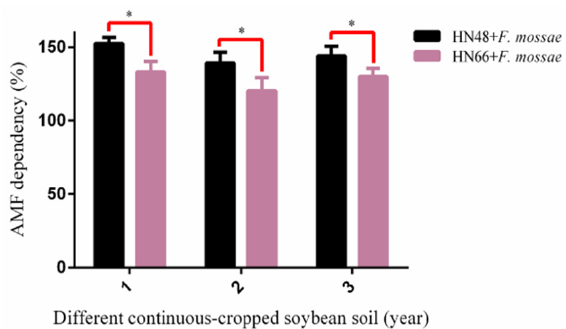
Figure 4. The AMF dependence of two soybean cultivars in the different year of continuously ‐ cropped soybean soils: 1 means soybean were planted the normal soil; 2 means soybean were planted in one ‐ year continuous cropping soybean soil; and 3 means soybean were planted in three ‐ year continuous cropping soybean soil. Each value represents the average of six independent experiments and the error bars represent standard deviations. Asterisks indicate the significance of differences between the samples. p values were calculated by Student’s t ‐ test. Single asterisk indicates p < 0.05.